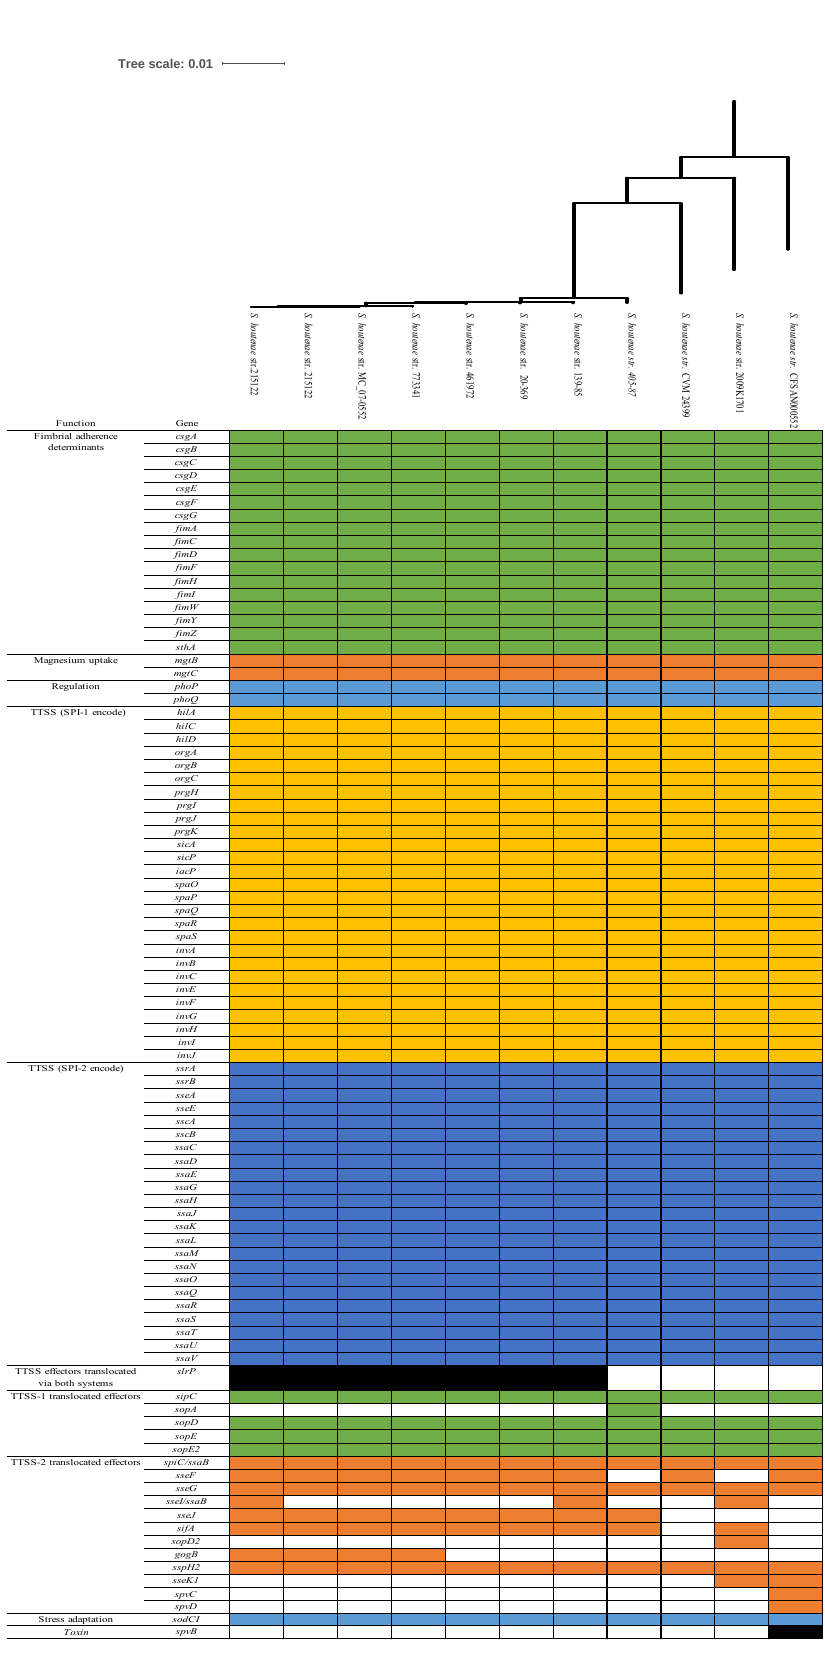
Figure 3. Virulence gene profile of 11 Salmonella enterica subsp. houtenae strains including strain